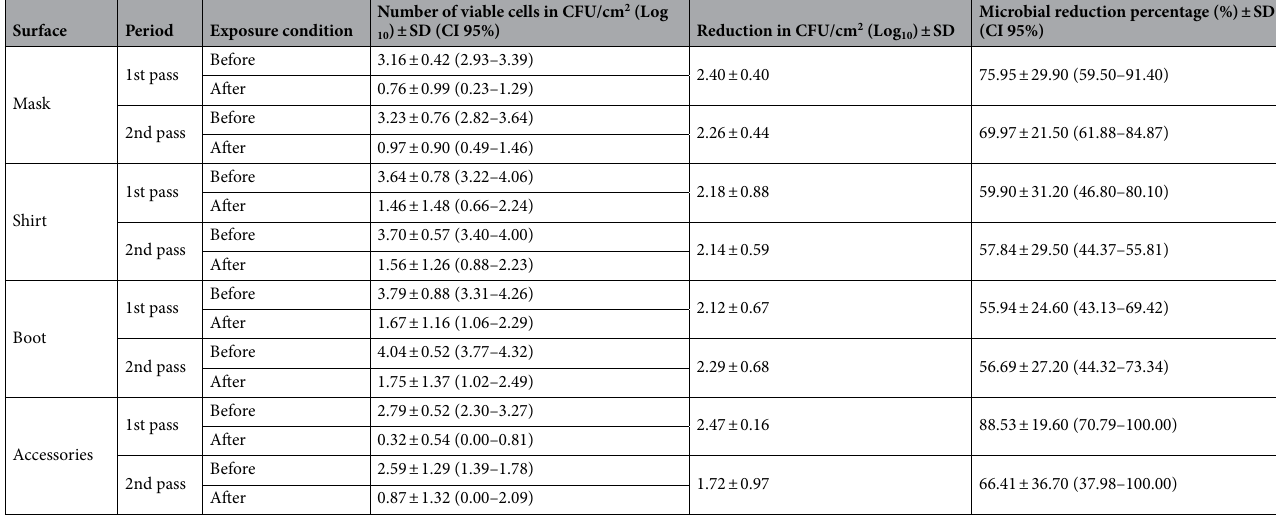
Table 1. Microbiological evaluation of the surfaces of different participants’ garments after using the disinfection technology. SD standard-deviation, CI 95% confidence interval of